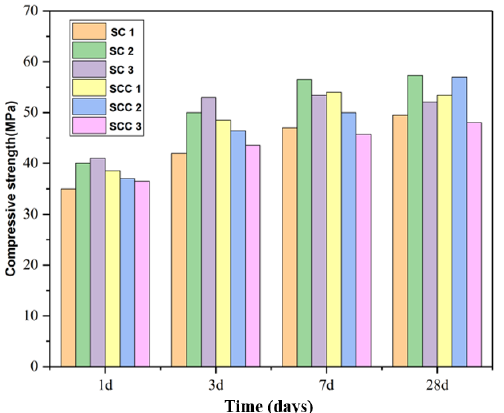
Figure 4. Compressive strength of samples SC1-SC3 and SCC1-SCC3 at different curing times.